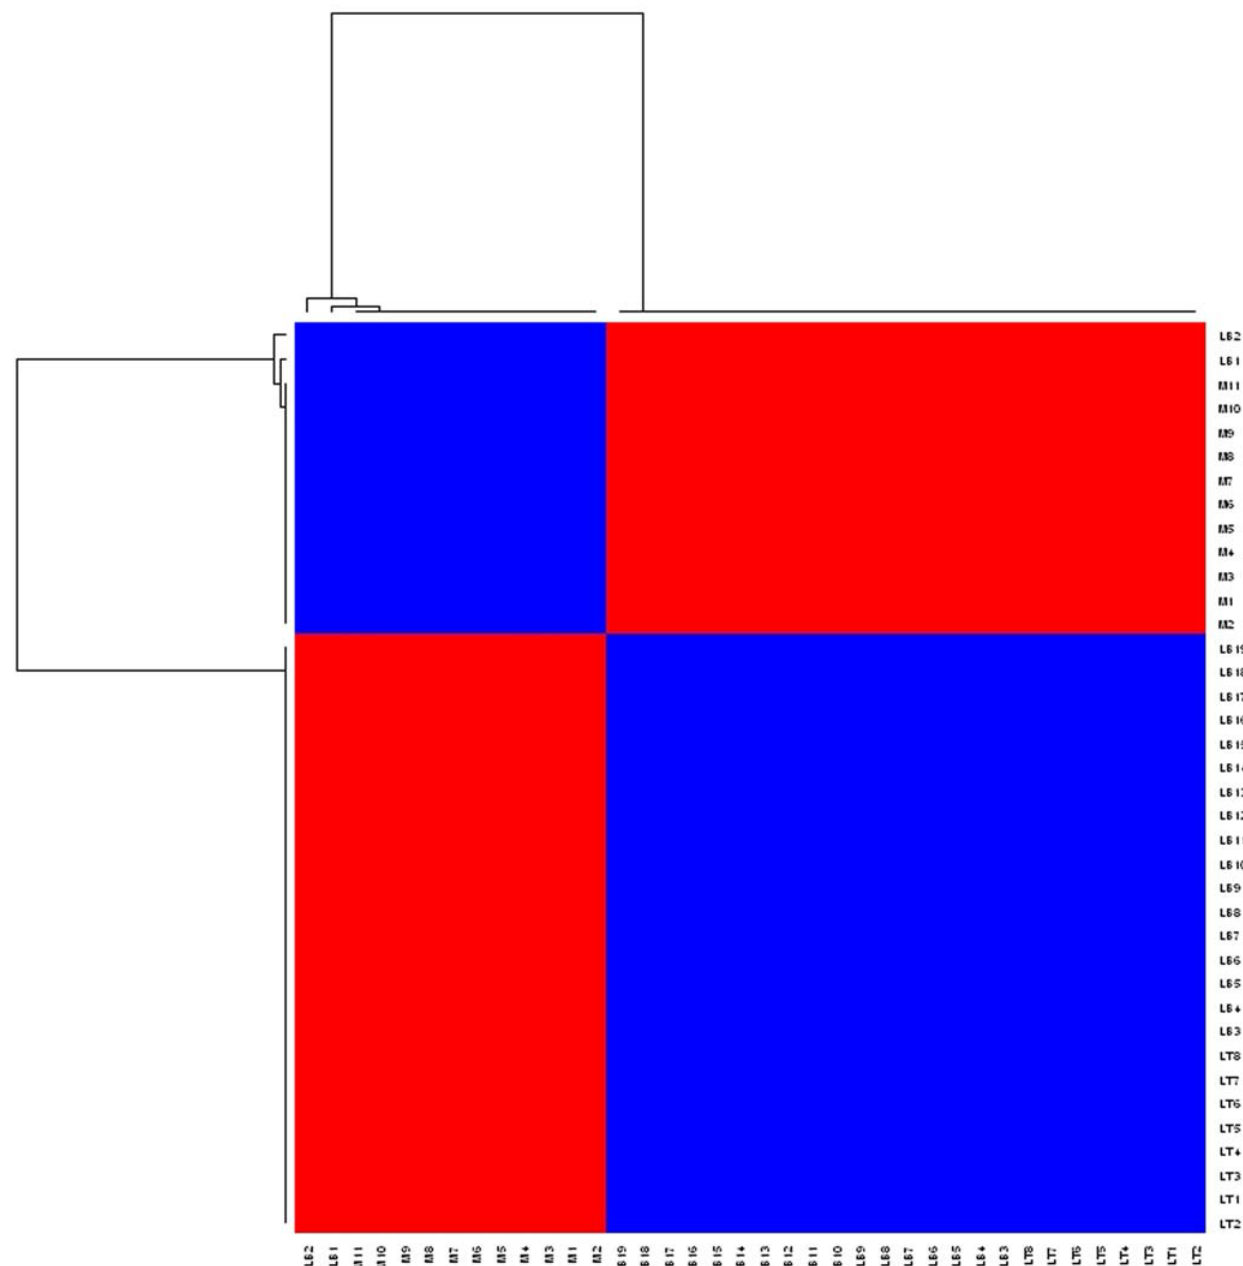
PLoS Computational Biology |